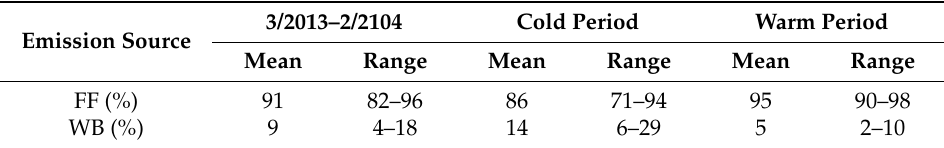
Table 1. Mean relative contribution (%) of fossil fuel (FF) and wood burning (WB) to aerosol absorption at 880 nm, during 1 year and for the warm and cold period separately. The range of contributions provided corresponds to the estimates by the use of the different α wb values (1.7–3.0).